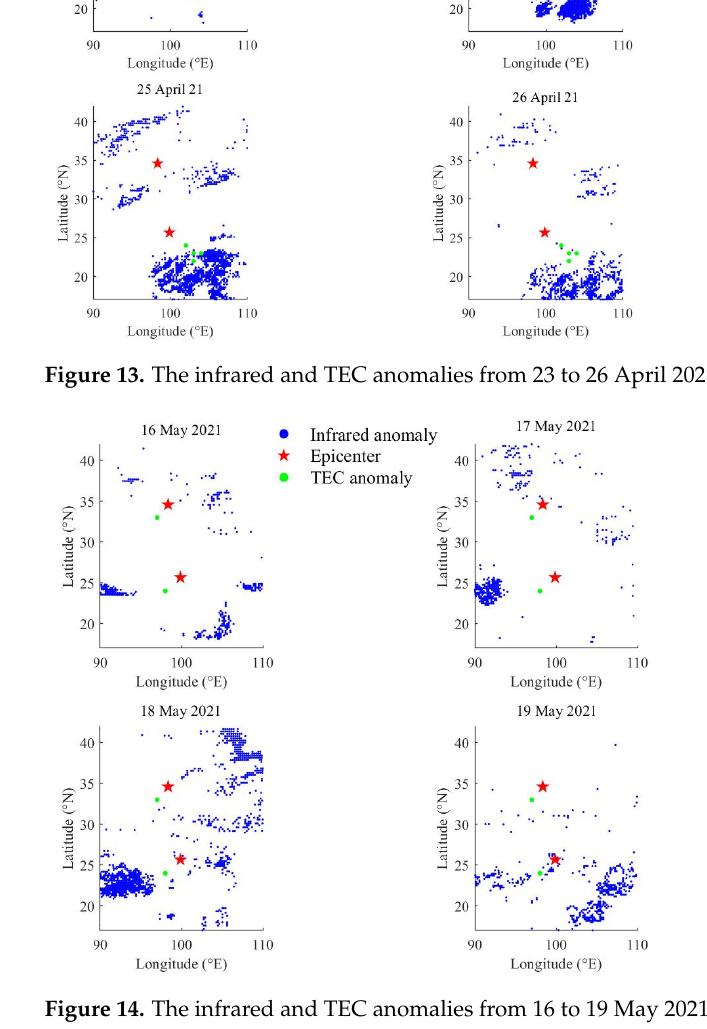
Figure 14. The infrared and TEC anomalies from 16 to 19 May 2021.